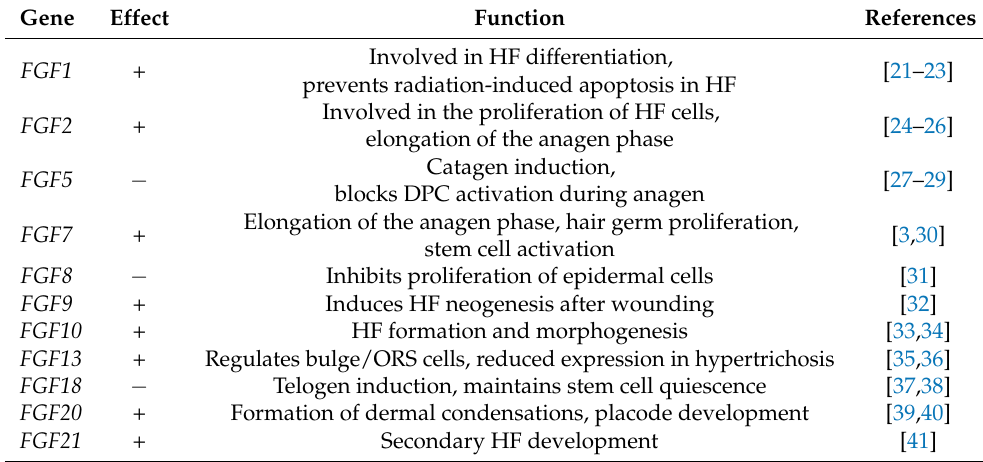
Table 1. Effects of FGFs in hair growth (+/ −